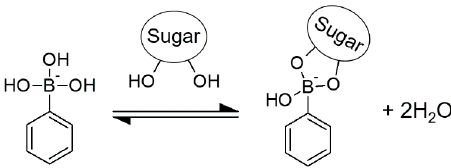
Figure 1. Dynamic covalent bond formation between phenylboronic acid (PBA) and sugar.